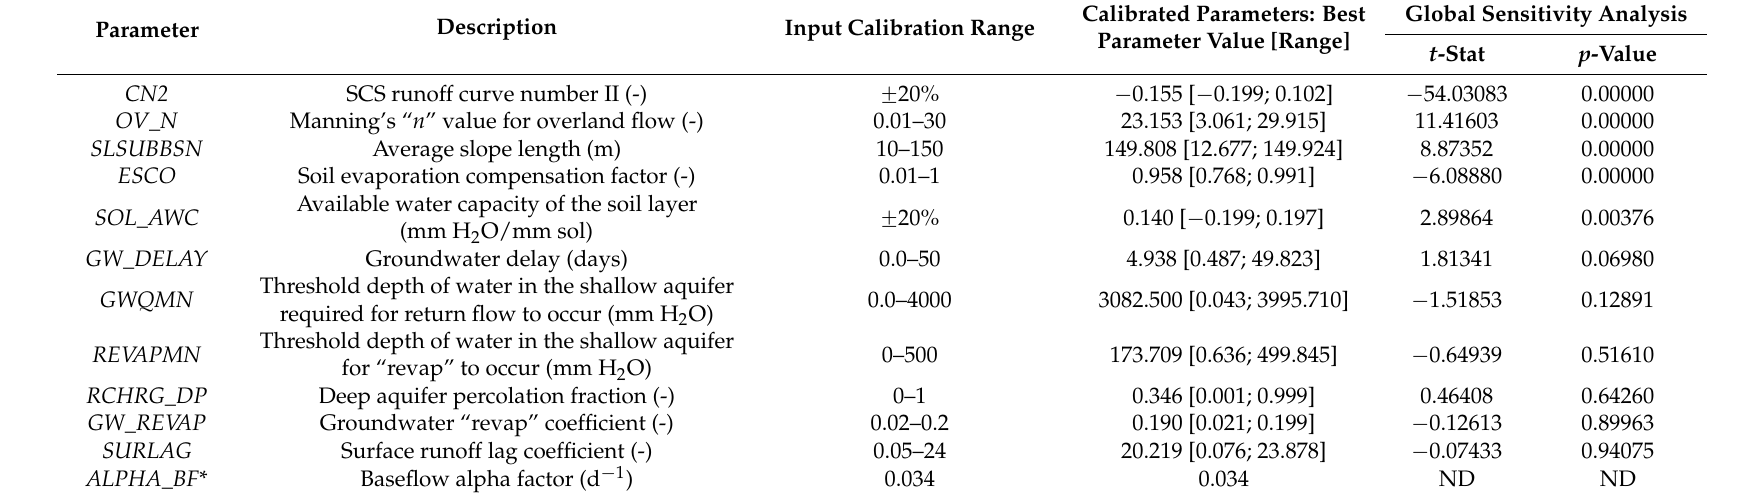
Table 5. Summary of the SWAT model parameters calibrated on the Bani catchment at Douna on a daily time